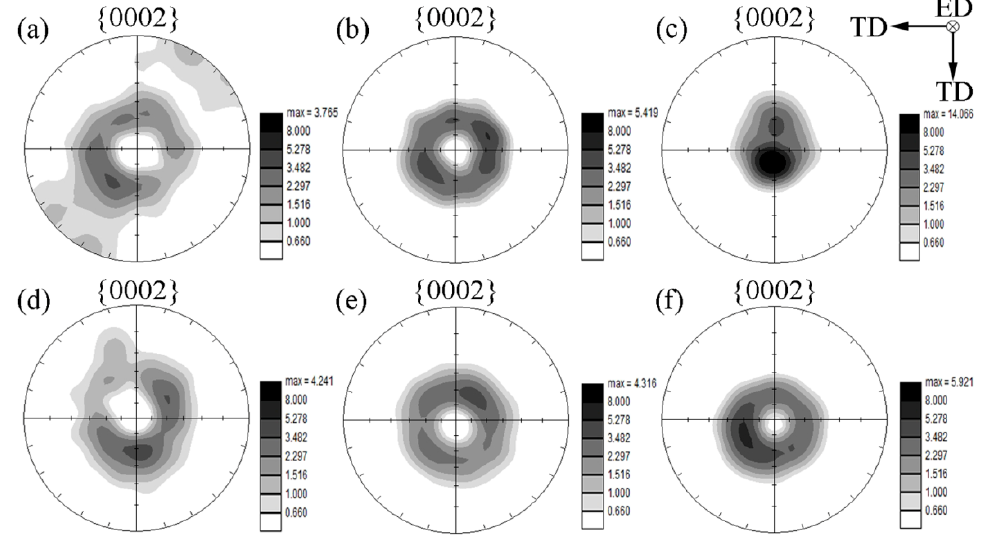
Figure 6. {0002} pole figures of CECed ZK61 alloy rods: ( a ) 350 ◦ C 2P; ( b ) 350 ◦ C 4P; ( c ) 350 ◦ C 16P; ( d ) 300 ◦ C 2Ps; ( e ) 250 ◦ C 2P; and, ( f ) 200 ◦ C 2P.